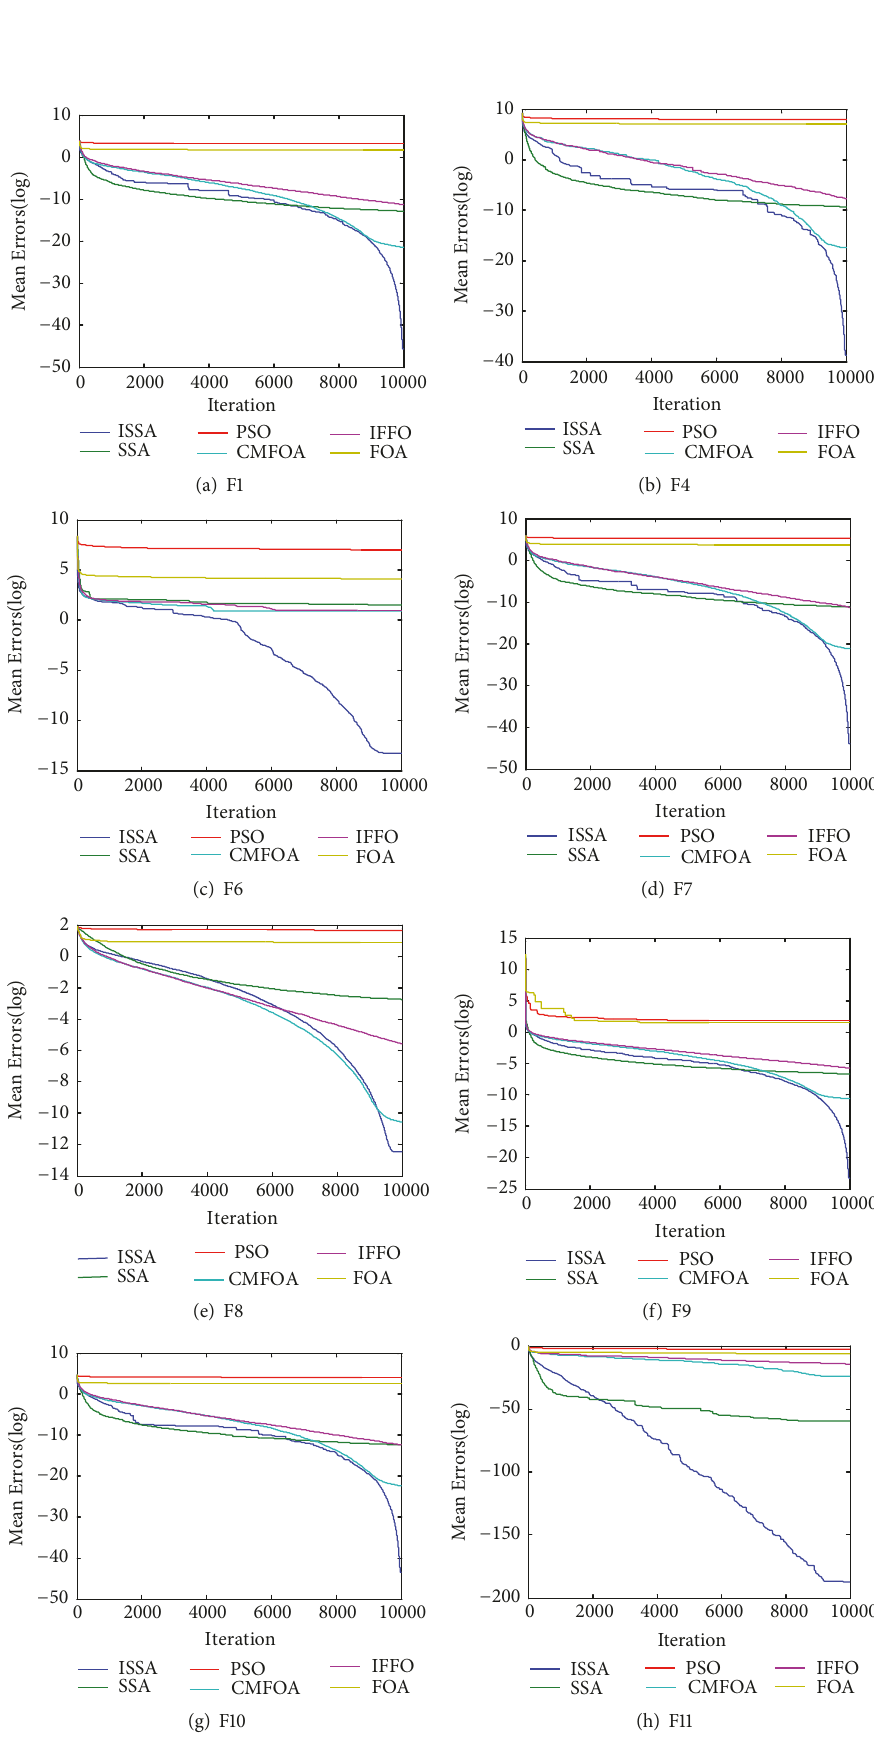
Figure 1: Convergence rate comparison for representative unimodal functions ( n =